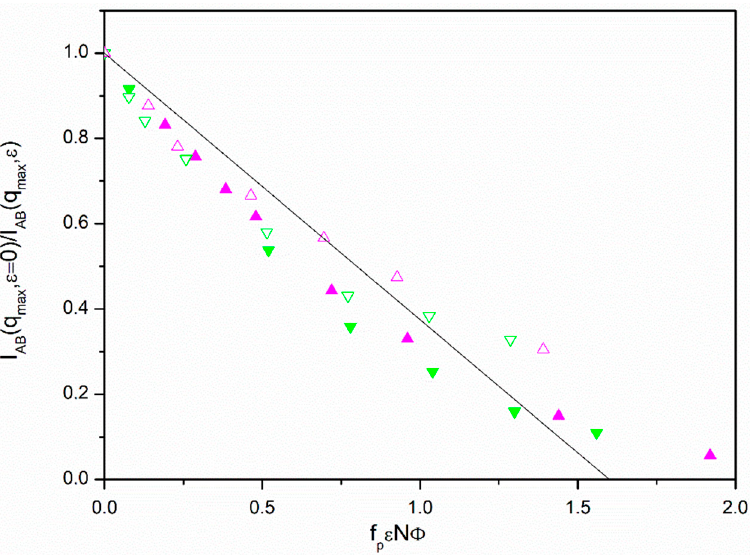
Figure 3. Ratio between the scattering functions obtained with opposite optical contrast factors for A and B units without segregation and with different values of ε vs. f P ε N Φ for f = 12. Magenta triangles up: N = 145; green triangles down: N = 73. Filled symbols correspond to Φ ≅ 0.275 and open symbols correspond to Φ ≅ 0.135. Solid black line: best fit of the points of Figure 2 in the linear region of low ε values.